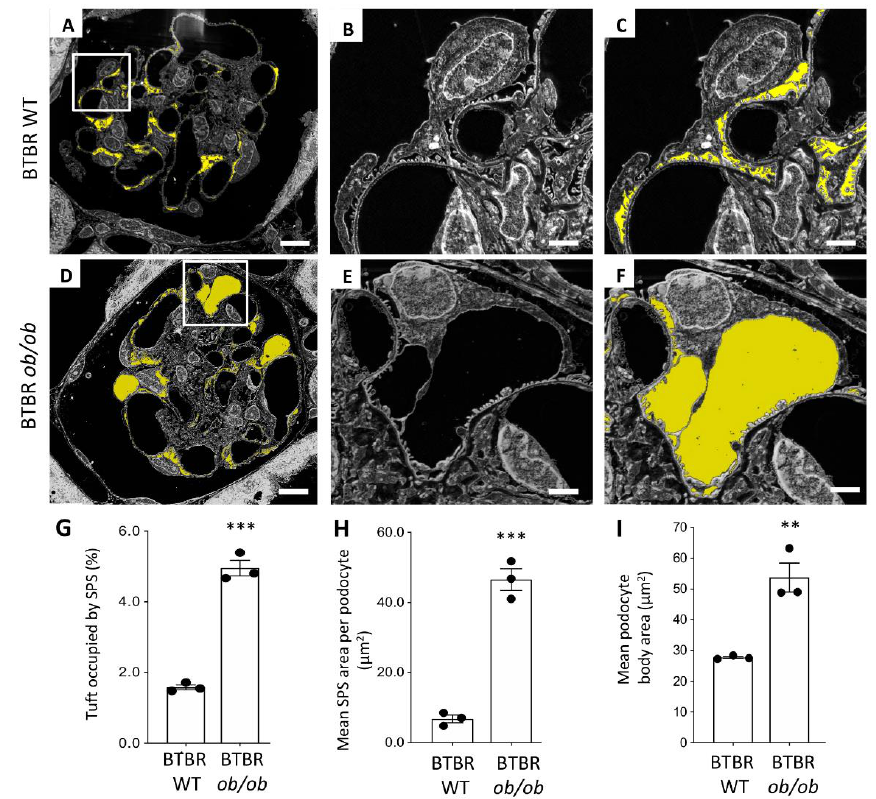
Figure 6. Morphological changes in the subpodocyte space and in podocytes documented using